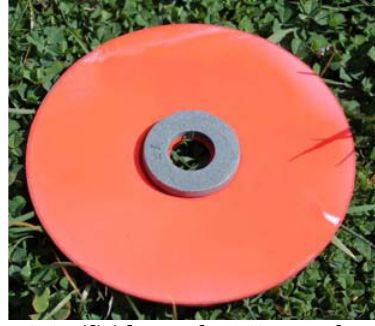
Figure 2. Artificial target for UAV